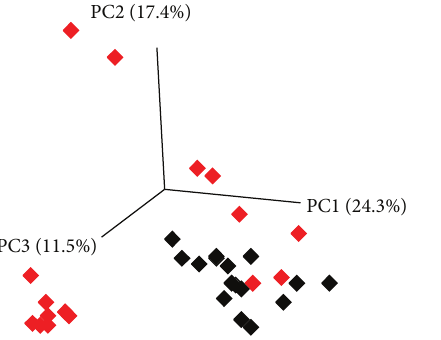
Figure 2: Plot of the first three dimensions of the Principal Component Analysis of the normalized and autoscaled VOC data of the 2012 and 2013 tomato samples from the Basilicata region (black symbols) and the Emilia Romagna region (red symbols).